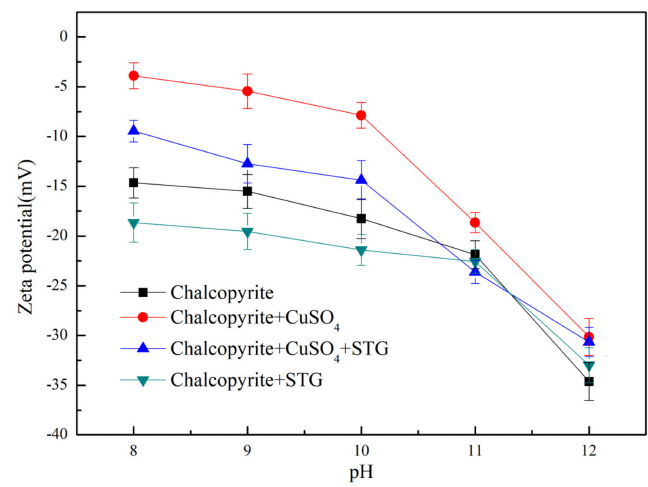
Figure 5. The Zeta potential of chalcopyrite under di ff erent pH values; c(Cu 2 + ) = 1 × 10 − 3 mol / L, c(STG) = 1.5 × 10 − 3 mol / L, c(BX) = 1 × 10 − 3 mol /